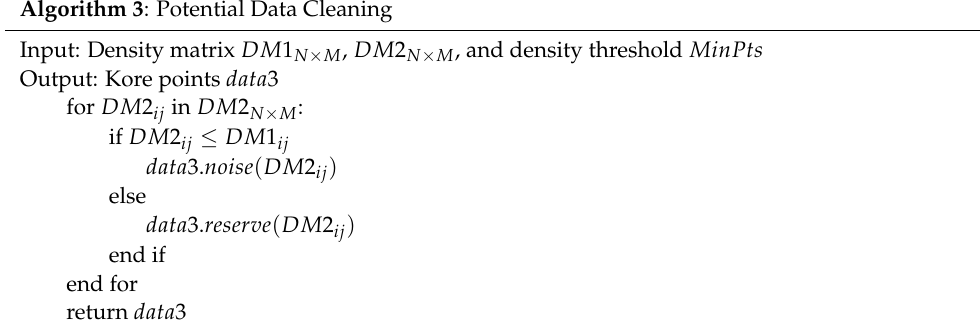
Algorithm 3 : Potential Data